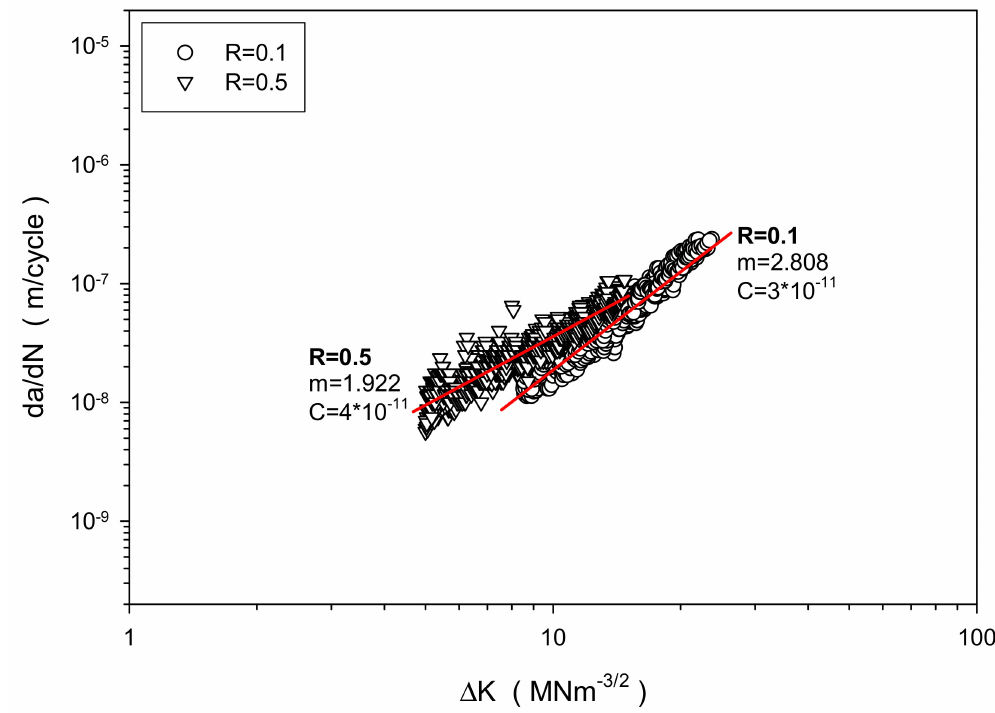
Figure 19. Experimental scatter from repeat fatigue crack growth tests performed on Ti-834 bar stock material.